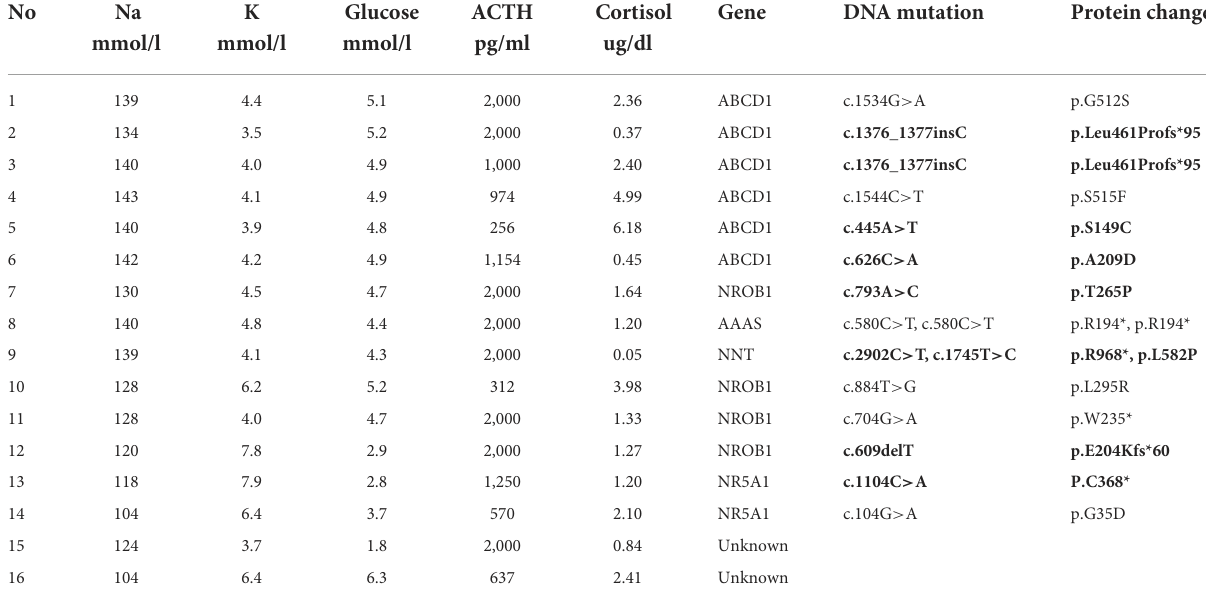
TABLE 2 Lab tests and genetic tests of patients with PAI.